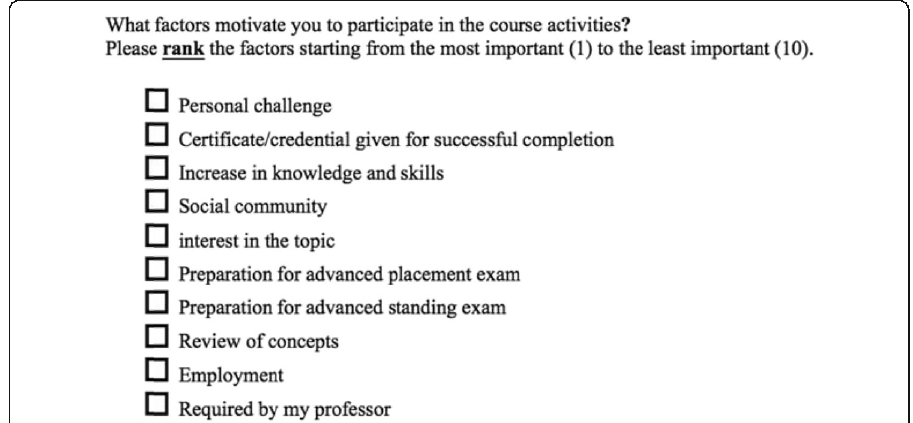
Fig. 2 Rank of motivators for